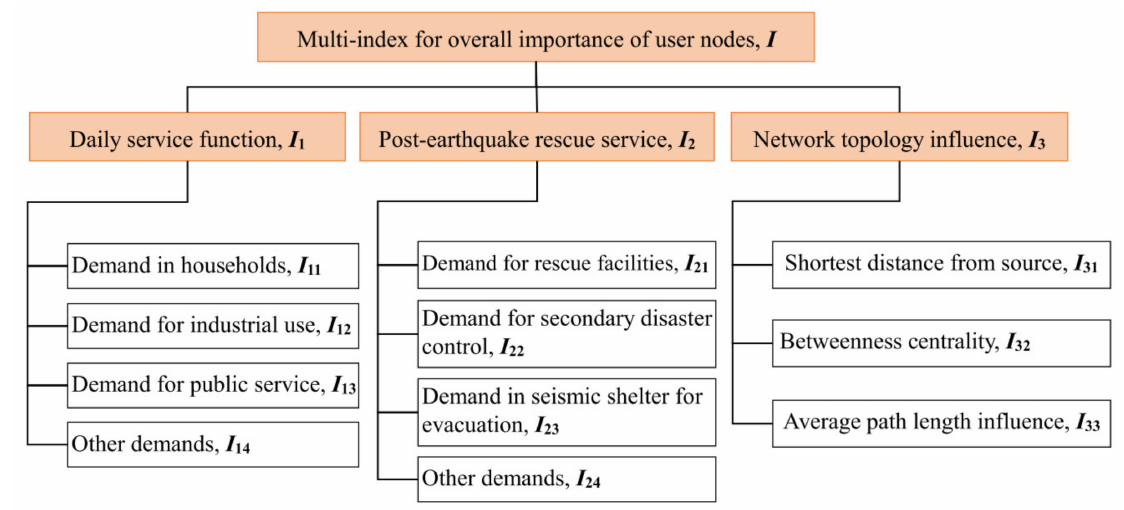
Figure 2. The multi-index model for the overall nodal importance